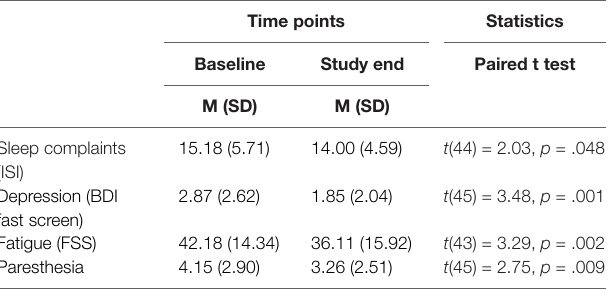
TABLE 2 | Descriptive and inferential statistical overview of values for subjective sleep, depression, fatigue, and paresthesia at baseline and at the study end.